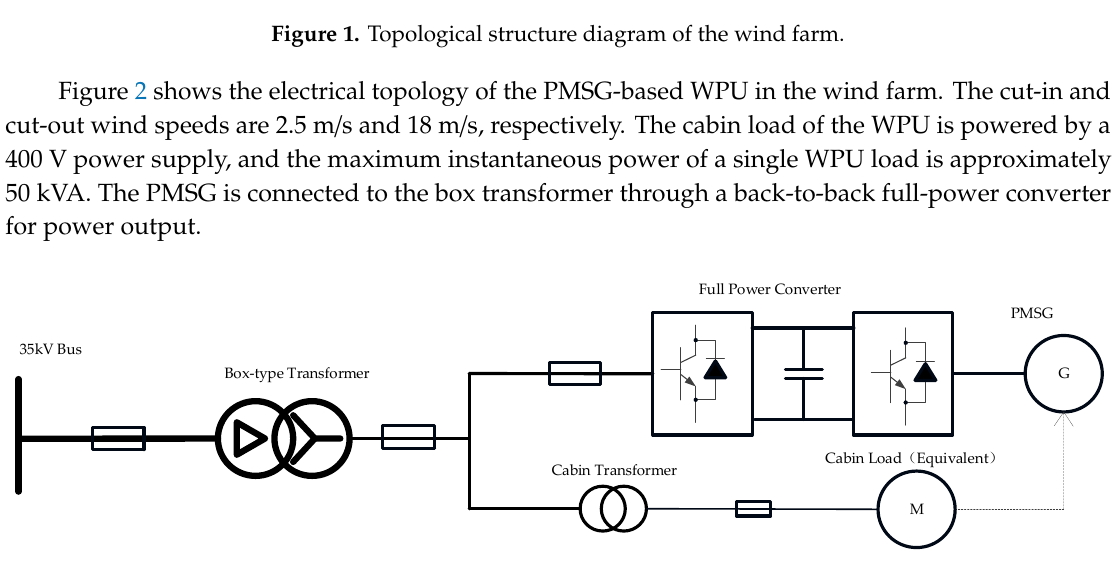
Figure 2. Topological structure diagram of a wind power unit.